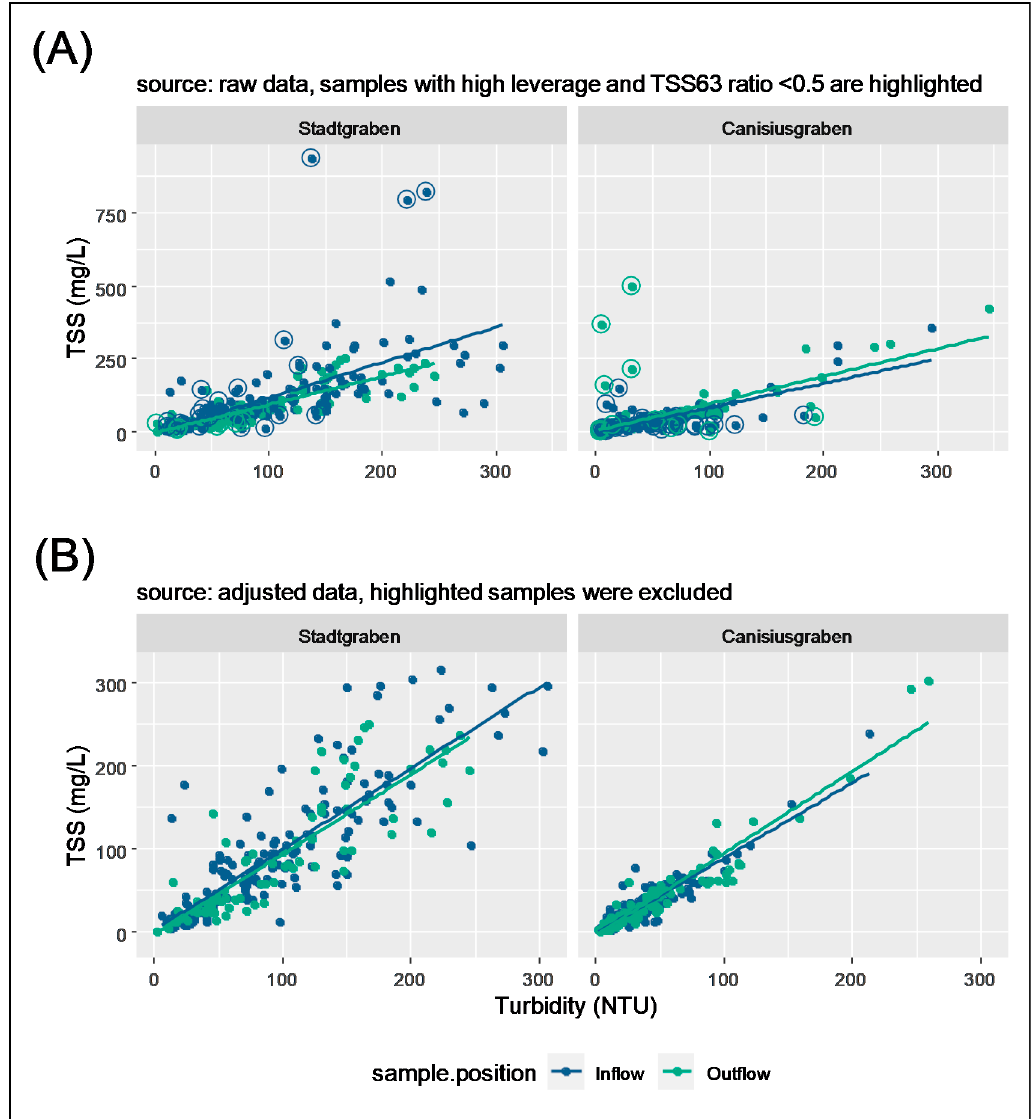
Figure 4. Linear regression of turbidity and TSS before ( A ) and after data preparation ( B ). Dots with circles in ( A ) highlight samples with a high leverage and a TSS63 ratio <0.5.